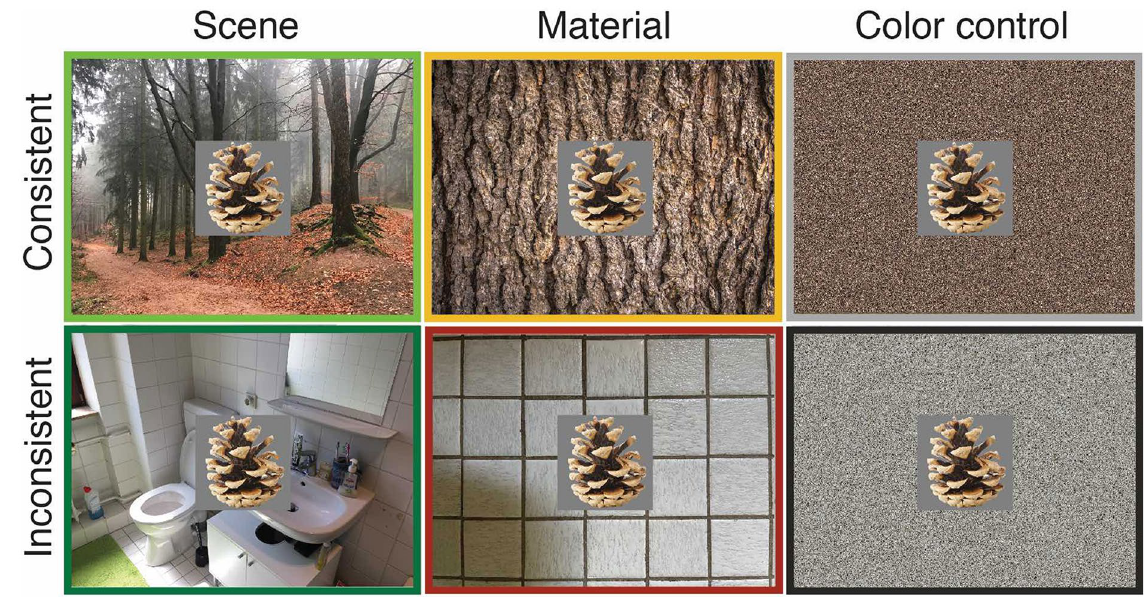
Figure 1. Example stimuli from the six experimental conditions of Experiment 1. Note that in Experiment 2, the color control condition (scrambled materials) was not included to maximize the number of trials in the other conditions. Colored frames were added for illustration